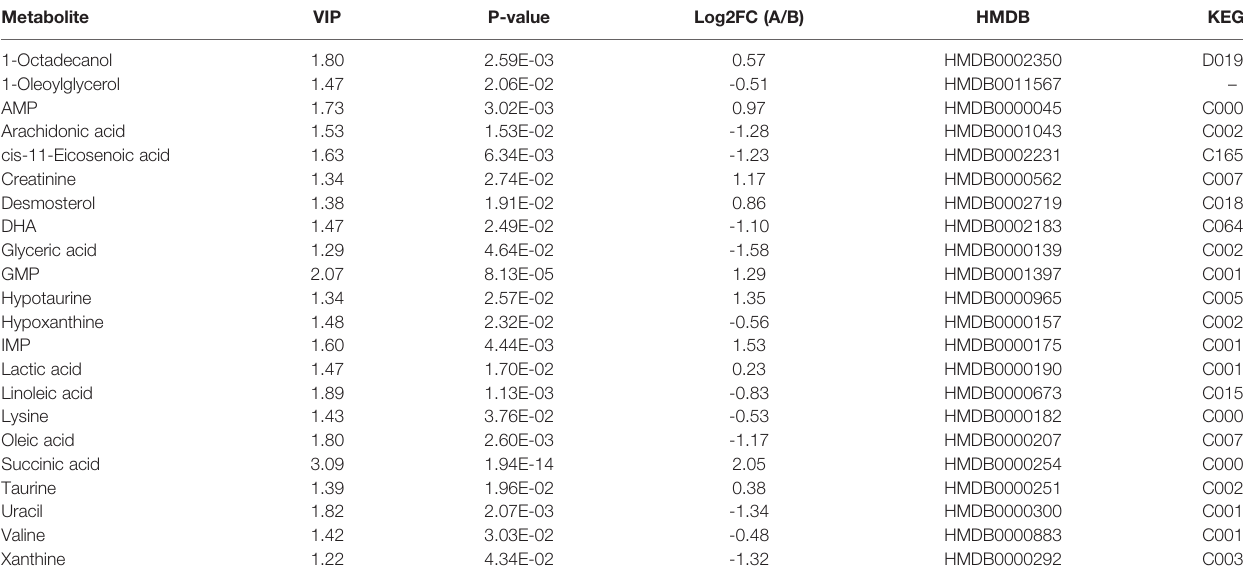
TABLE 2 | The metabolic differences between invasive and non-invasive NFPA. Metabolite